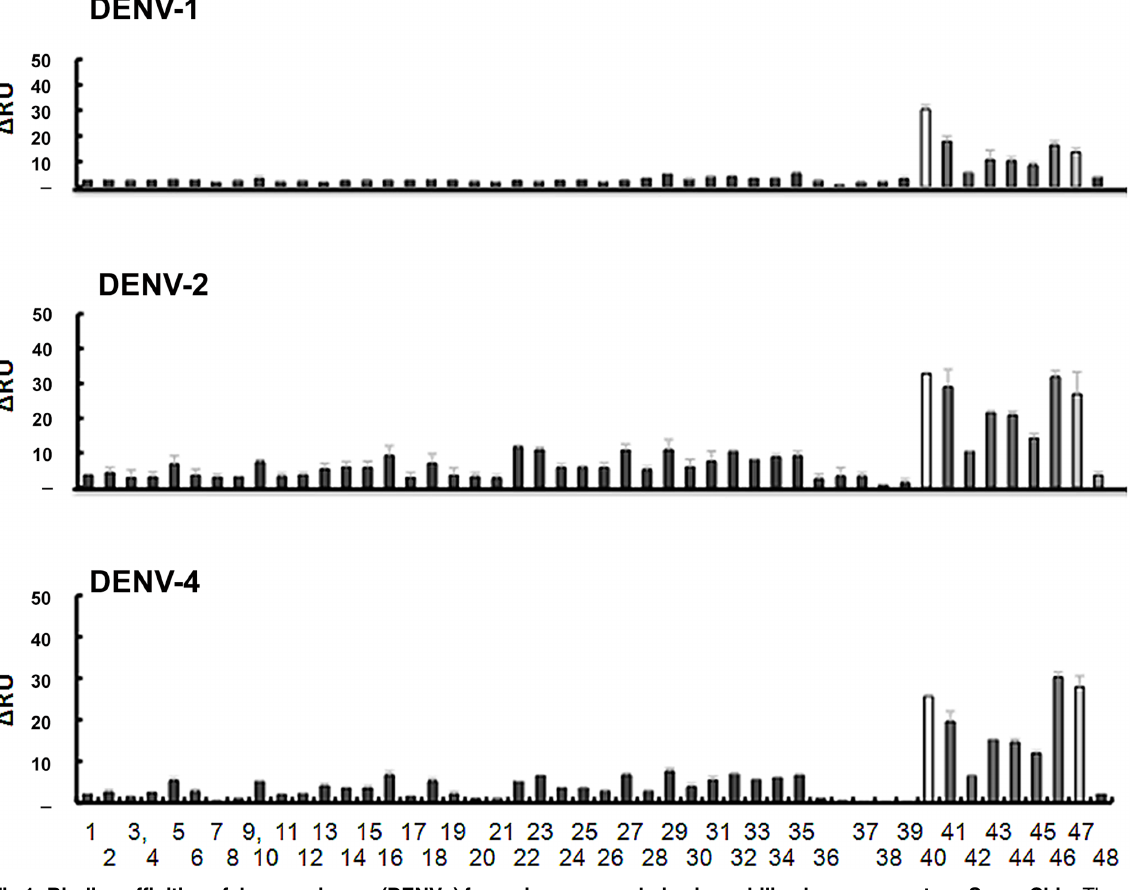
Fig 1. Binding affinities of dengue viruses (DENVs) for various sugar chains immobilized on an array-type Sugar Chip. The map of immobilization, an example of the data on the binding, and the list of sugar chains are shown in S1 Fig. DENVs re-suspended in PBS-T at the concentration of 1.5 – 12 μ g/mL (total viral protein) were loaded onto the sugar chain chip at a flow rate of 150 μ L/min, and the signal data (brightness, recorded by a CCD camera, indicating the binding affinity) were collected by the manufacturer ’ s analytical software (Toyobo). The signal intensities of 8 independent data points for each spot were averaged and plotted on the